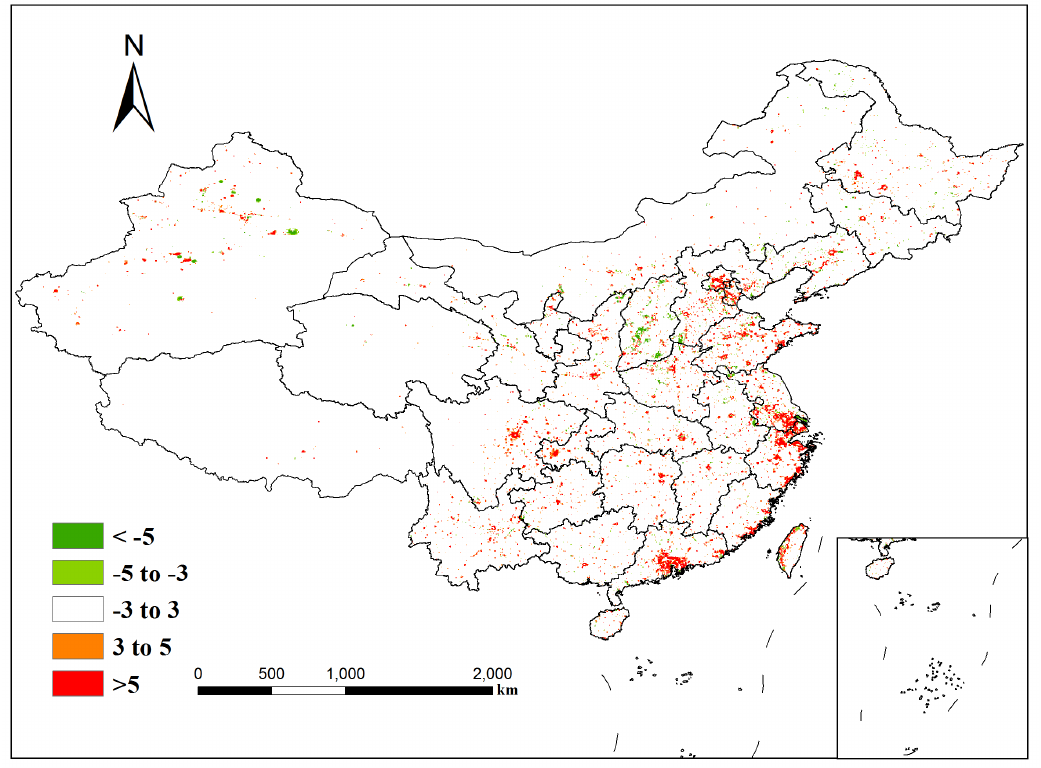
Figure 5. Change in brightness (calibrated digital number) between 1992–1996 and 2000–2004.